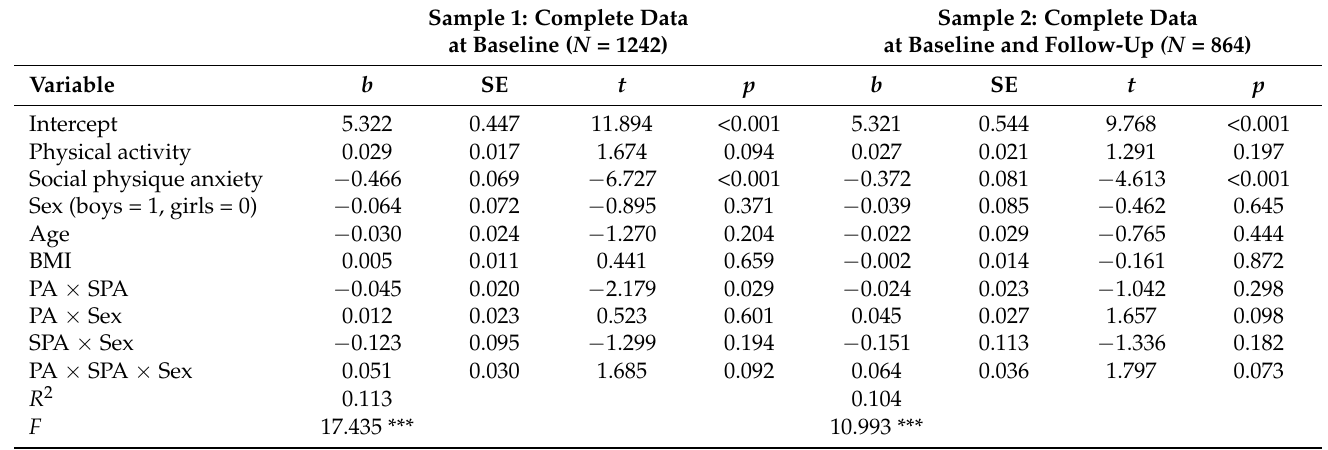
Table 3. Cross-sectional conditional process model with life satisfaction at baseline as dependent variable, physical activity as predictor, and social physique anxiety and sex as moderators. Sample 1: Complete Data Sample 2: Complete Data at Baseline ( N = 1242) at Baseline and Follow-Up (N =